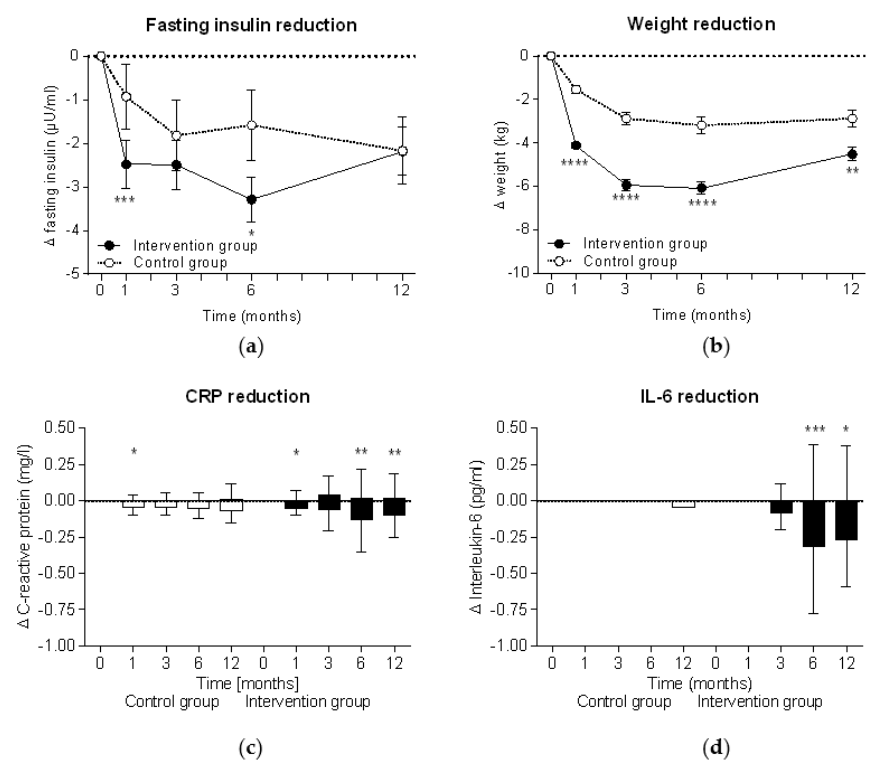
Figure 2. Intention-to-treat analyses of improvements during the study. Mean ± standard errors of changes in ( a ) fasting insulin levels and ( b ) body weight are shown and the Mann-Whitney test was used for intergroup analyses of the intervention group ( n = 301) and the control group ( n = 145). Tukey plots with median ± interquartile range are shown for ( c ) C-reactive protein (CRP) and ( d ) interleukin 6 (IL-6). Wilcoxon signed rank test was used for intragroup analyses (*, p < 0.05; **, p < 0.01; ***, p < 0.001; ****, p <